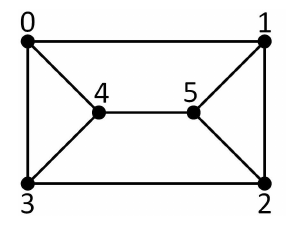
Figure 12. The prism